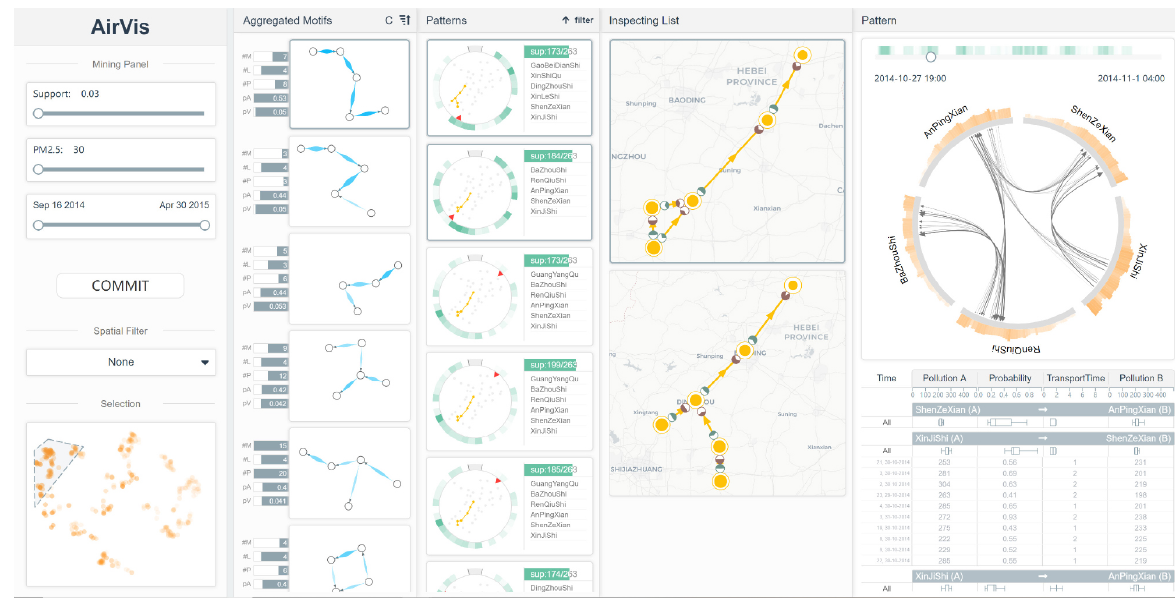
Fig. 8 Views in AirVis from left to right hierarchically organize numerous propagation patterns of air pollution. Reproduced with permission from Ref. [87], c (cid:13) IEEE